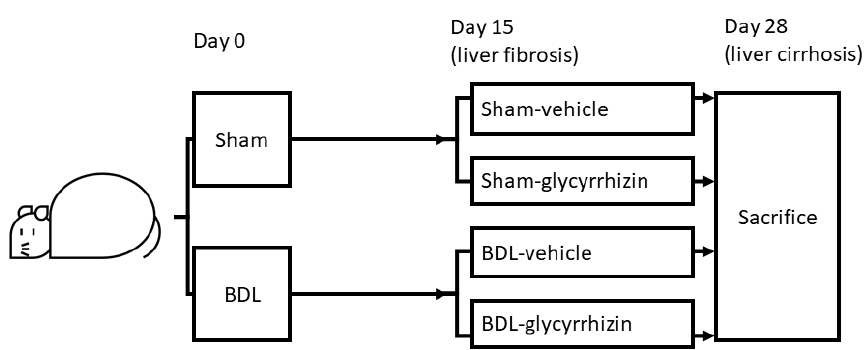
Figure 1. Experimental design. The rats received bile duct ligation (BDL) or sham operation. Treatments were started on the 15th day after operations, when liver fibrosis developed in BDL groups. After 2 weeks of treatments, experiments were performed on the 28th day after operations.